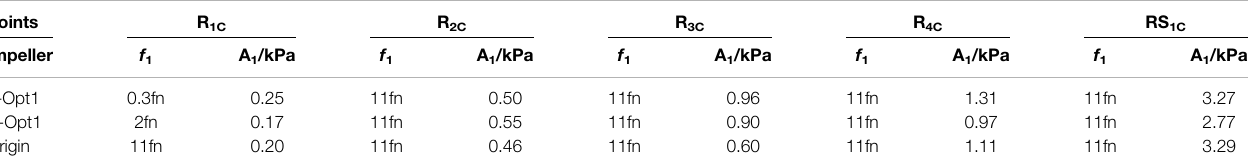
TABLE 5 | Dominant frequency and its corresponding amplitude of points in impeller.